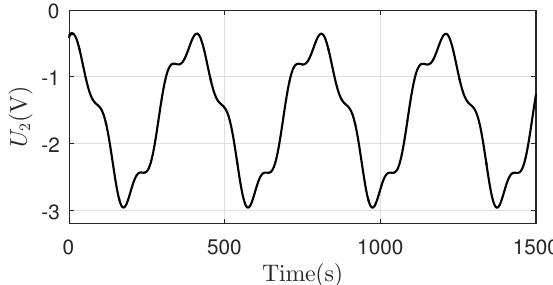
Figure 27. Control input U 2 in floating motion with a constant velocity and variable pitch angle